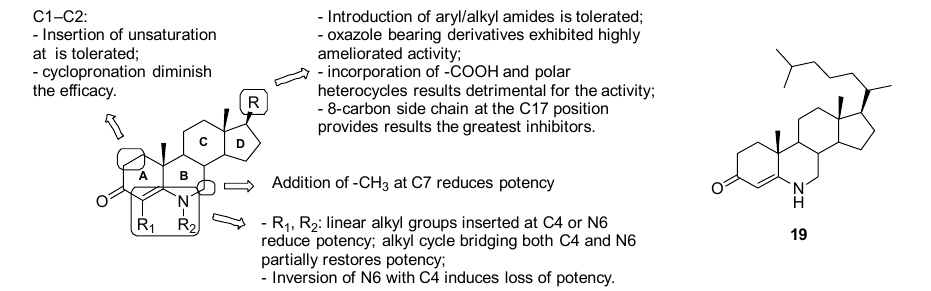
Figure 26. SARs of 6-azasteroids and the chemical structure of compound 19.